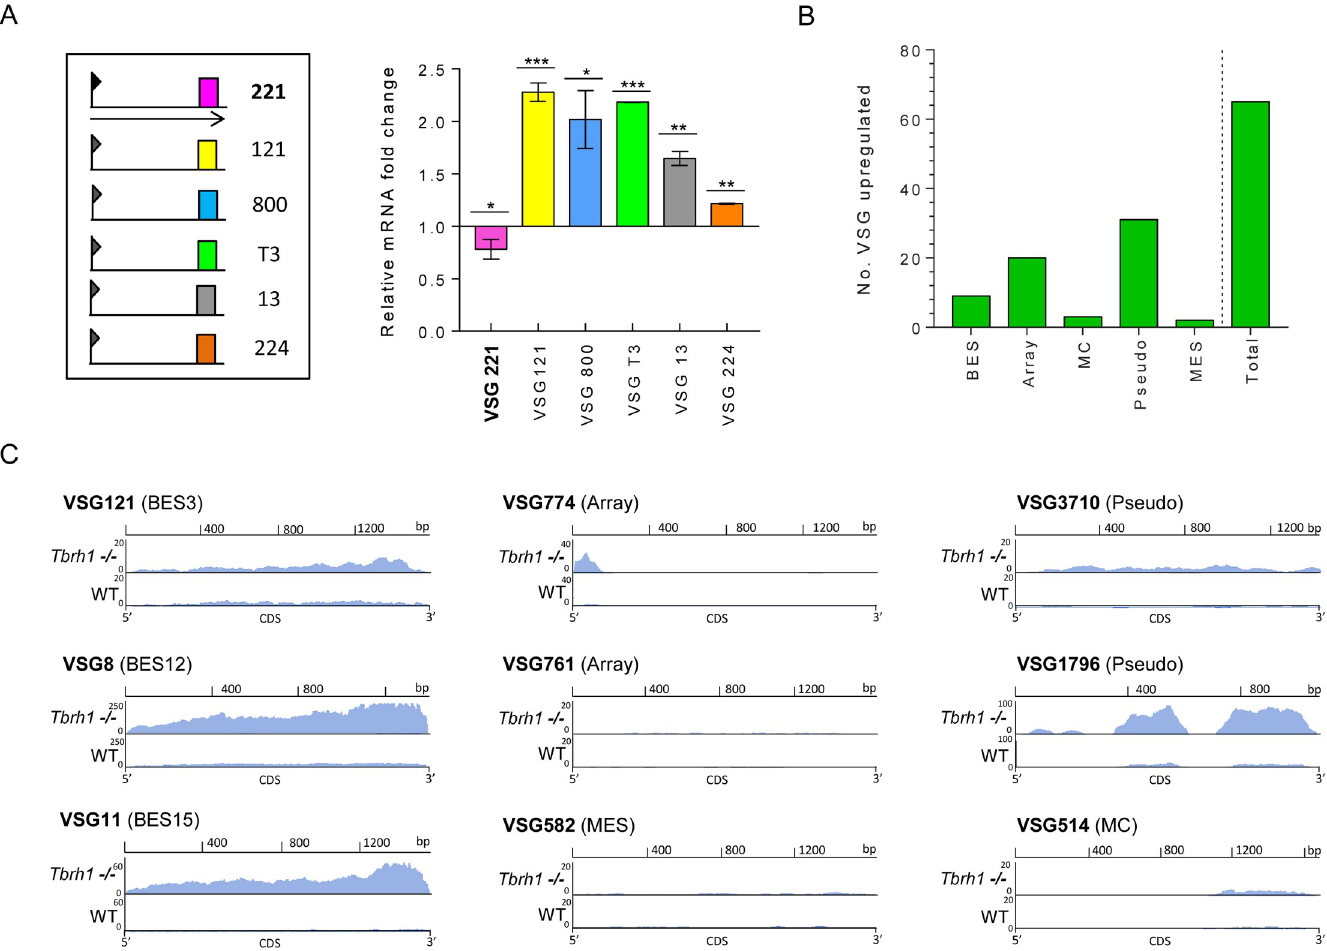
Fig 3. Loss of T . brucei RNase H1 results in increased transcription of silent VSGs. A. The left panel provides a simplified diagram of VSG expression sites (ES) used to generate a protective surface coat in the bloodstream T . brucei cells used in this study; only telomere-proximal VSG s (coloured boxes, numbered) from a selection of ES are shown, and the single ES being actively transcribed (encoding VSG221 , pink) is denoted by an arrow extending from the promoter (flag). The right panel shows a graph of VSG RNA levels (corresponding to the ES diagram, and determined by RT-qPCR) in TbRH1 null mutants ( Tbrh1 -/- cells), plotted as fold-change relative to levels of the cognate VSG RNA in wild type cells (WT427 1.2); VSG 221 is in bold to indicate it is in the active ES of wild type cells, and data are presented as mean +/- SD for three independent experiments; � P < 0.05, �� P < 0.005, ��� P < 0.0005 (one-way t-test). B. A graph depicting the number of VSG genes that display > 1.5-fold increase in RNA abundance (determined by RNA-seq, and normalised to gene length and total number of reads) in Tbrh1 -/- cells relative to WT; the total number is sub-categorised depending on whether the VSGs have been localised to the bloodstream ES (BES), are intact genes in the subtelomeric arrays (array), are in mini- chromosomes (MC), are pseudogenes (pseudo), or are in the ES transcribed in the metacyclic life cycle stage (MES). C. Plots of normalised RNA-seq read depth abundance (y-axes) relative to CDS position (x-axes) for a selection of the above VSGs; VSG identity numbers are from [16].